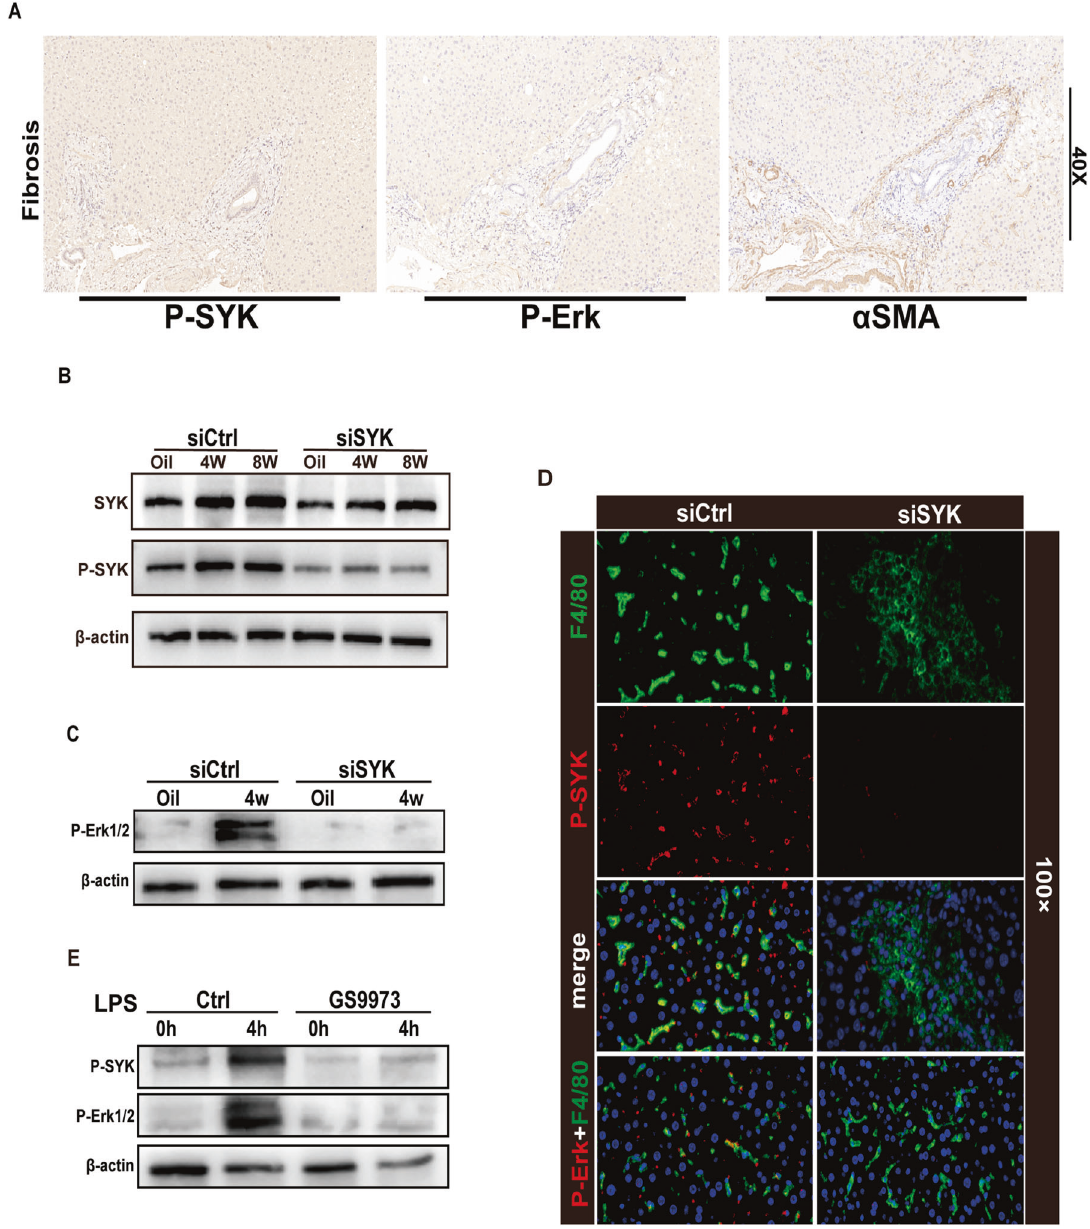
Fig. 3 Inhibiting MoMFs SYK blocked Erk phosphorylation. A IHC of Human fi brotic liver α -SMA, p-SYK, P-Erk (magni fi cation 40x). B Western blot was used to measure the protein expression of SYK and p-SYK in the liver of mice injected with CCL4 4 and 8 w, oil as a control. C Detected the protein level of macrophage p-Erk after silencing liver macrophage syk. D Confocal immuno fl uorescence to check the expression of p-SYK and p-Erk in F4/80 macrophages (Zoom 100x). E In the presence or absence of the syk inhibitor GS9973, the protein levels of p-SYK and p-Erk were detected after stimulating BMDM with LPS for 4